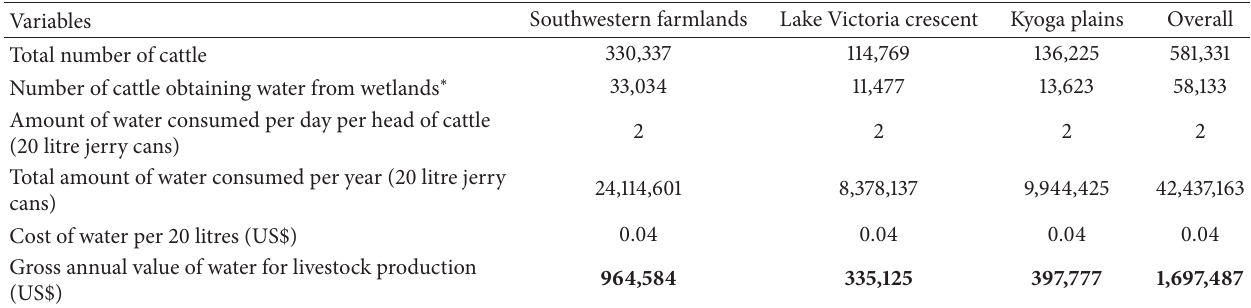
Table 7: Monetary value of wetlands for livestock watering in three agro-ecological zones of Uganda.